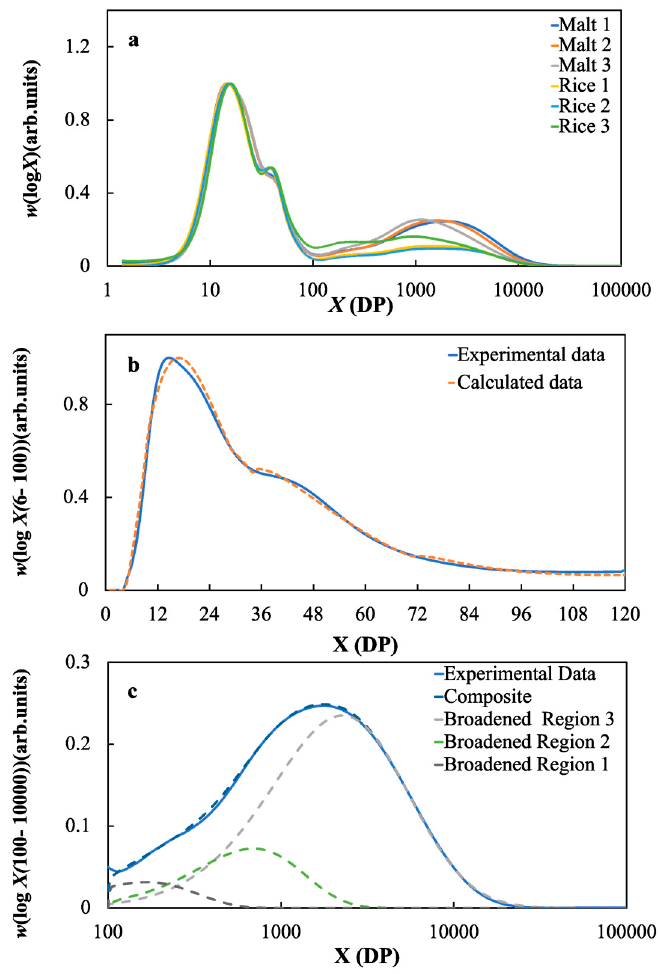
Figure 1. The weight chain length distributions of debranched malts and rice starches as a function of DP (degree of polymerization) ( a ); a comparison of a typical fit of the model to experiment for Malt 3 with ( b ) amylopectin and ( c ) amylose. Fitting parameters shown in Table 1. All data normalised to the maximum peak of amylopectin.